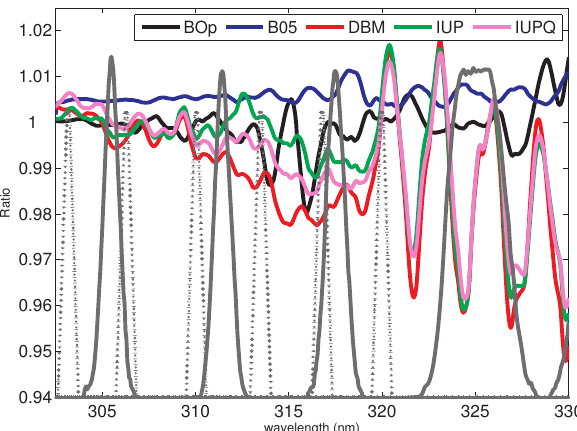
Fig. 2. Ratio of the cross sections of this study to the IGACO Bass & Paur (IGQ4). The cross sections are interpolated to a common res- olution base on that of B&P (0.1nm) and smoothed to the Brewer resolution (triangle slit with FWHM of 0.6nm). The Dobson (con- tinuous) and Brewer (dotted) slit functions are shown in gray. DBM and IUP show the same structures compared with B&P. There is a small but significant difference between the interpolated value of IUP and the values from the quadratic polynomial